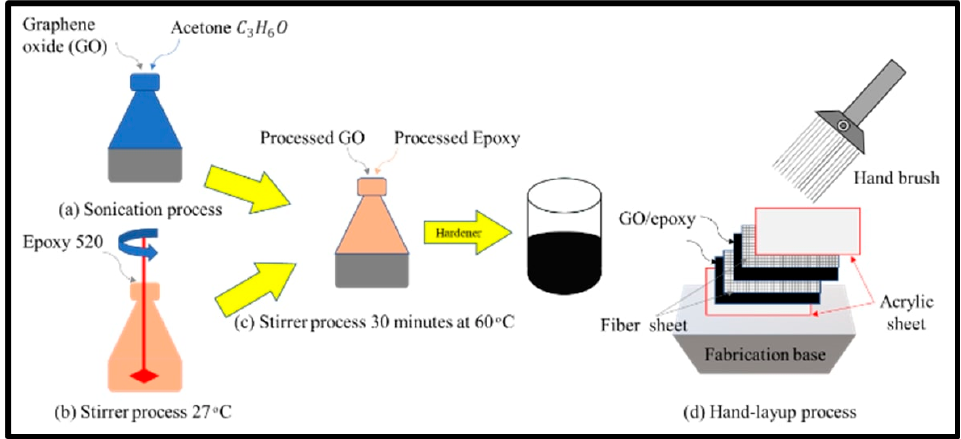
Figure 1. Nanocomposite fabrication procedure ( a ) Sonication process, ( b ) Stirrer process 27 °C, ( c ) Stirrer process 60 °C, ( d ) Hand-layup process. Table 1. Mechanical properties of G/C@FRNC laminates.